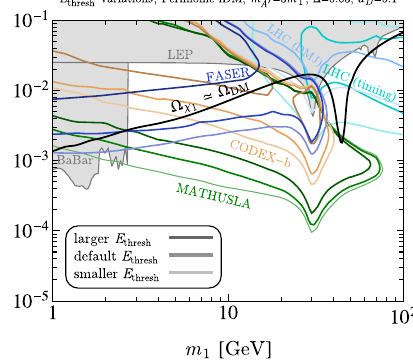
Fig. 17 Left: Lifetime of the 0 ++ glueball as a function of its mass. Right: Projected reach of CODEX-b, MATHUSLA (200 m × 200 m) and ATLAS at the full luminosity of the HL-LHC. The solid (dashed) ATLAS contours refer to the optimistic (conservative) extrapolations of the ATLAS reach, as discussed in Sect. 2.3.1. The horizontal dashed line indicates the reach of precision Higgs coupling measurements at the LHC [48]